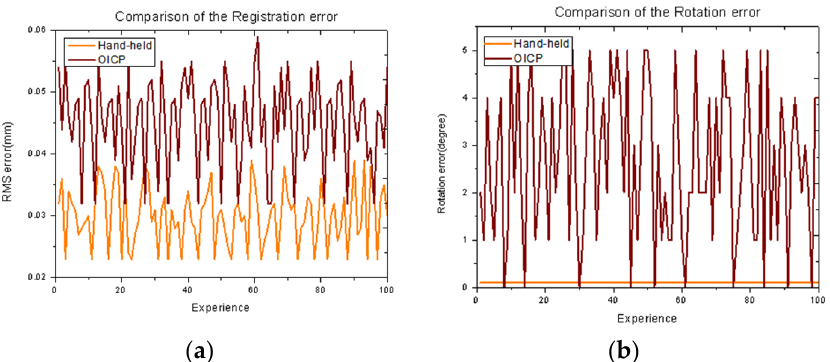
Figure 13. Comparison of the ( a ) registration error and ( b ) rotation error on random points by our OICP method and hand-held 3D scanner point cloud data. Ground truth rotation and translation lie randomly within ±5 degrees and ±0.5, respectively (point cloud overlap = 70%).